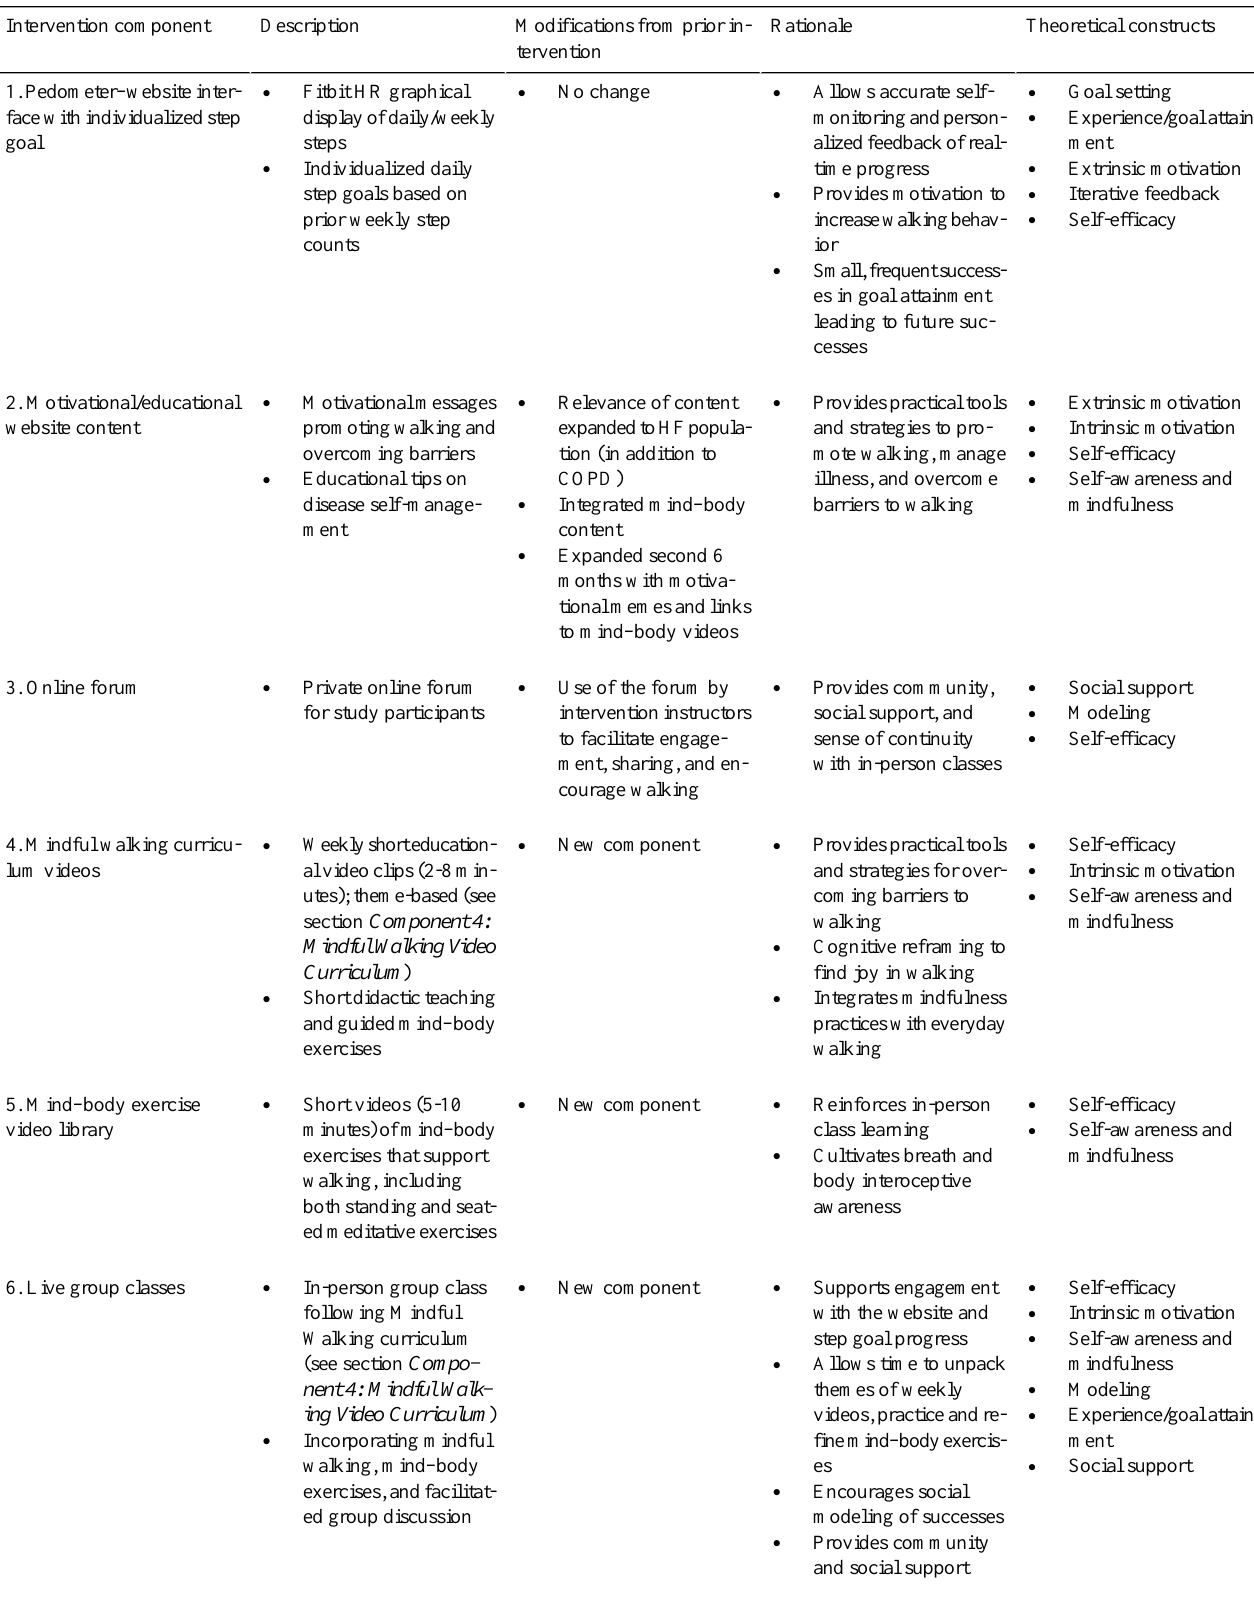
Table 1. Mindful Steps intervention